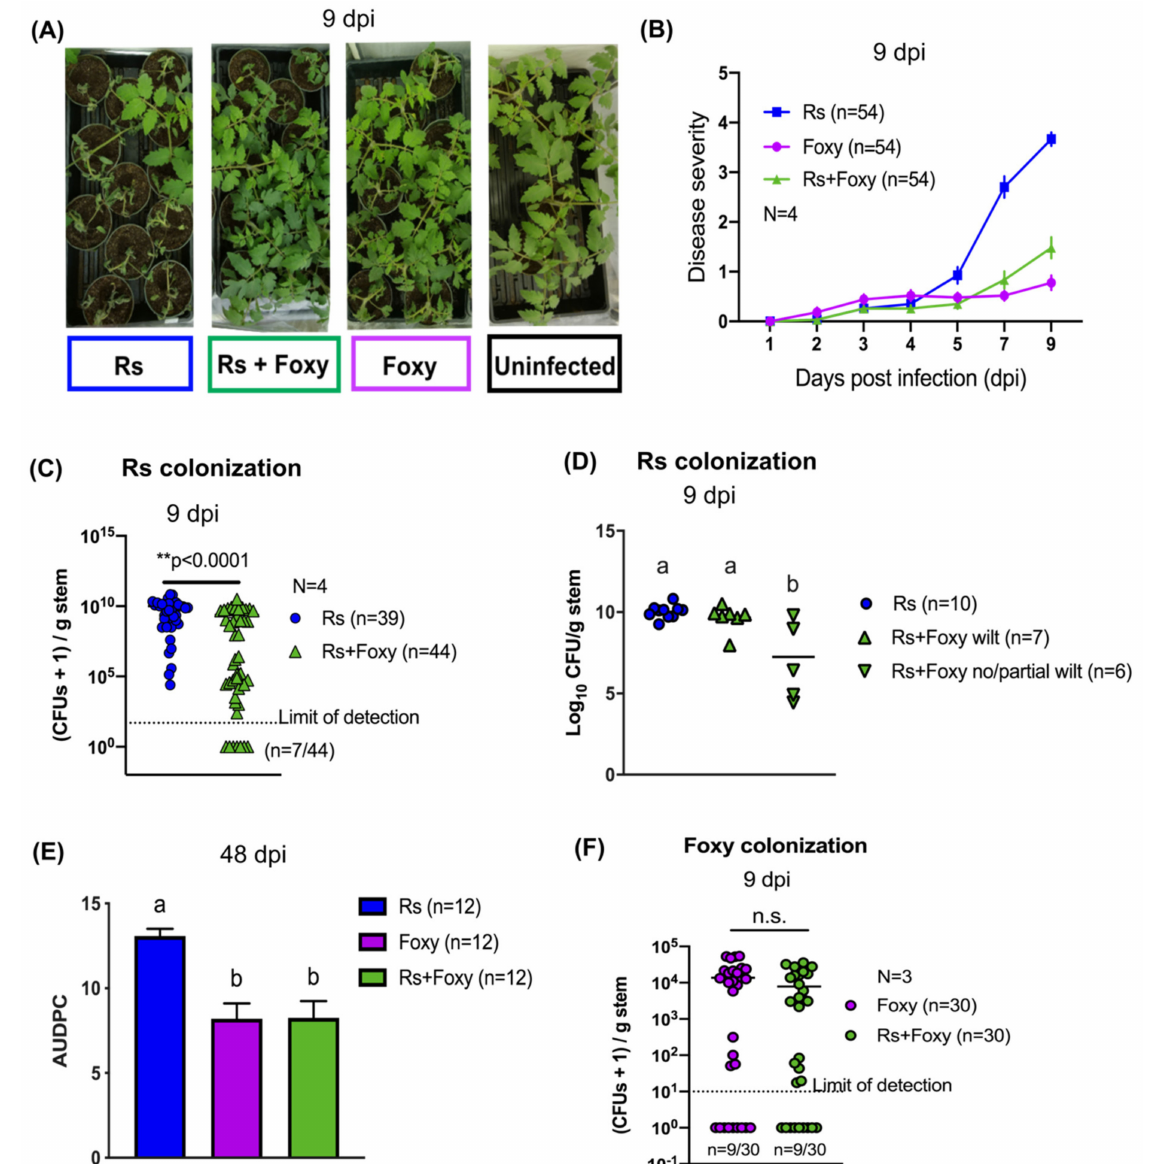
Figure 1. Co-infection reduces bacterial wilt severity. ( A ) Single-infected and co-infected showing differential wilting symptoms 9 days post infection (dpi). R. solanacearum = Rs; F. oxysporum (Foxy). ( B ) Wilt symptoms were scored every day for 9 dpi and quantified. Two-way repeated-measures ANOVA was performed with time x treatment p = 0.0001. Tukey’s multiple comparisons showed significantly different disease between Rs vs. Foxy ( p < 0.0001) and Rs vs. Rs+Foxy ( p < 0.0001). No significant difference in symptoms was observed between Foxy and Rs+Foxy ( p = 0.7867). ( C ) Bacterial colony forming units (CFUs) quantified 9 dpi from shoots 1 cm above the cotyledons showed reduced bacterial burden in co-infection compared to single R. solanacearum infections. All CFU data in this work is presented as CFUs+1 to take into account samples below the detection limit, denoted under each dataset. Mann–Whitney’s U test was performed with p < 0.0001. ( D ) Co-infected plants that fully wilted had bacterial burden equal to plants infected with only R. solanacearum (ANOVA p = 0.0011; Tukey’s p = 0.8259). Co-infected plants that showed no/partial wilt symptoms had bacterial burden lower than R. solanacearum single infections (Tukey’s p = 0.0011). ( E ) Disease was quantified over 48 days based on disease incidence. ANOVA was performed on AUDPC with p = 0.0001. No significant difference in overall disease was observed between co-infection and F. oxysporum single infections (Tukey’s p = 0.9993). ( F ) F. oxysporum CFUs quantified from shoot tissues 9 dpi show no significant differences in fungal burden. Mann–Whitney’s U test p =